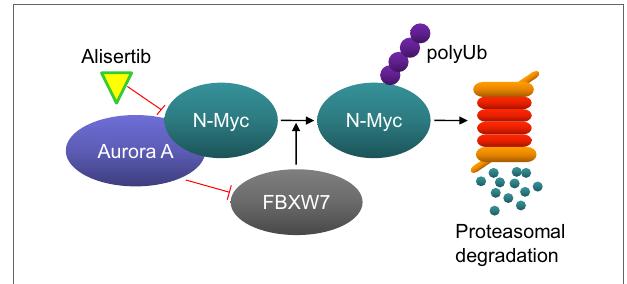
FiGURe 2 | Aurora A protects N-Myc from proteasome-mediated degradation . Aurora A binds to N-Myc, thereby preventing it from being ubiquitinated by the E3-ligase FBXW7. Alisertib binds to Aurora A and changes its confirmation in a manner that disrupts its interaction with N-Myc. N-Myc is than ubiquitinated by FBXW7 and subsequently degraded by the